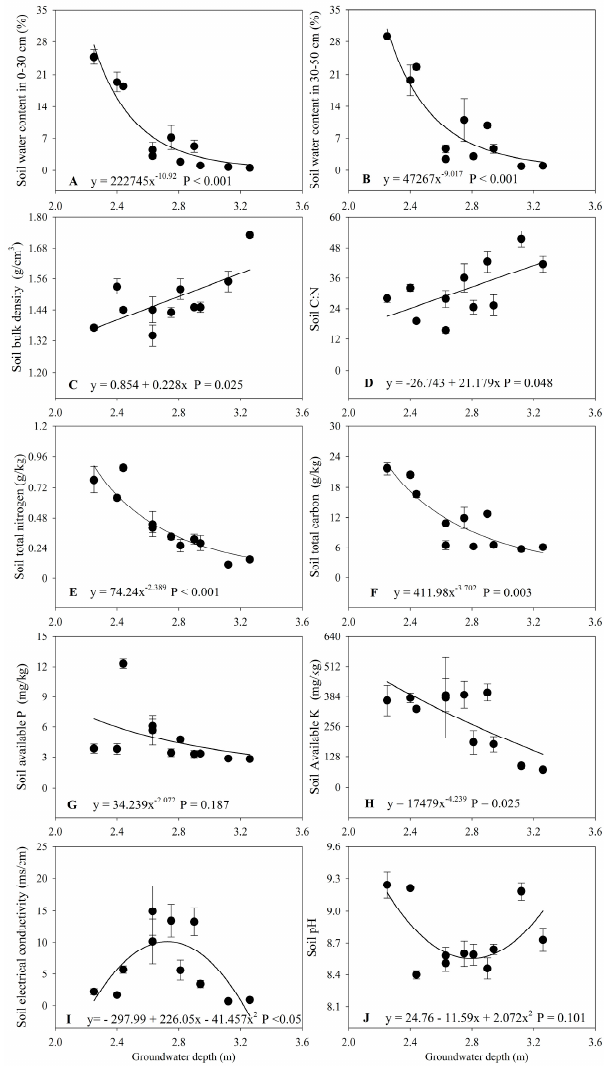
Figure 2. Relationship between soil properties and groundwater depth. ( A ) Gravimetric soil water content in 0–30 cm soil layer (%); ( B ) Gravimetric soil water content in 30–50 cm soil layer (%); ( C ) Soil bulk density (g/cm 3 ); ( D ) Soil C:N ratio; ( E ) Soil total N (g/kg); ( F ) Soil total C (g/kg); ( G ) Soil available P (mg/kg); ( H ) Soil available K (mg/kg); ( I ) Soil electrical conductivity (ms/cm); ( J ) Soil pH.